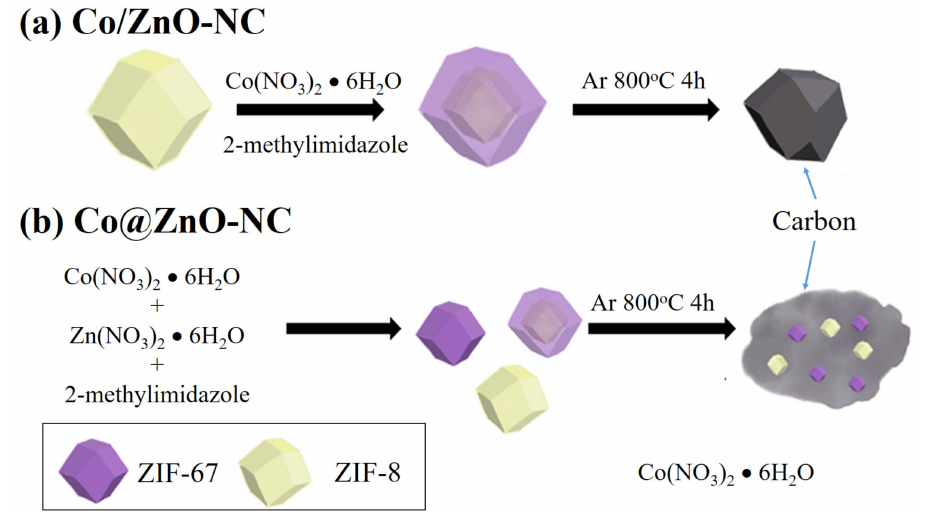
Figure 1. Schematic diagrams of ( a ) Co/ZnO-NC and ( b ) Co@ZnO-NC composite preparation.